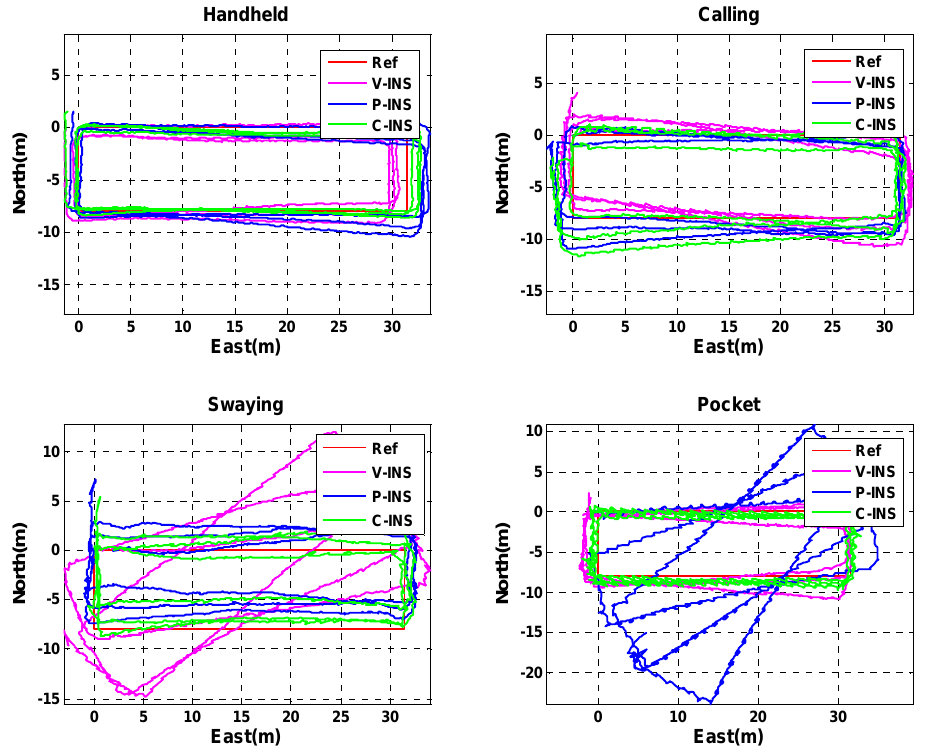
Figure 5. Trajectories of reference, V ‐ INS, P ‐ INS, and C ‐ INS solutions for four different smartphone positions.